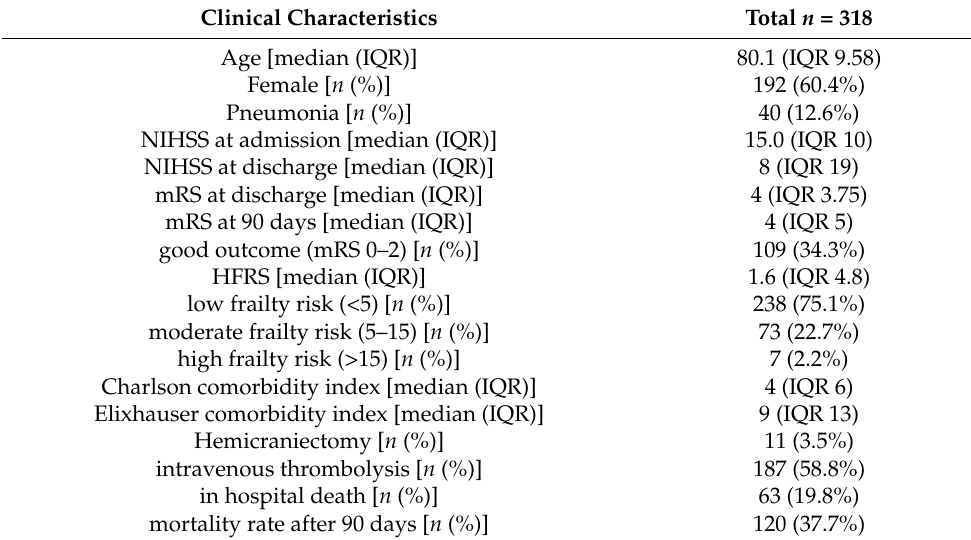
Table 1. Clinical characteristics.